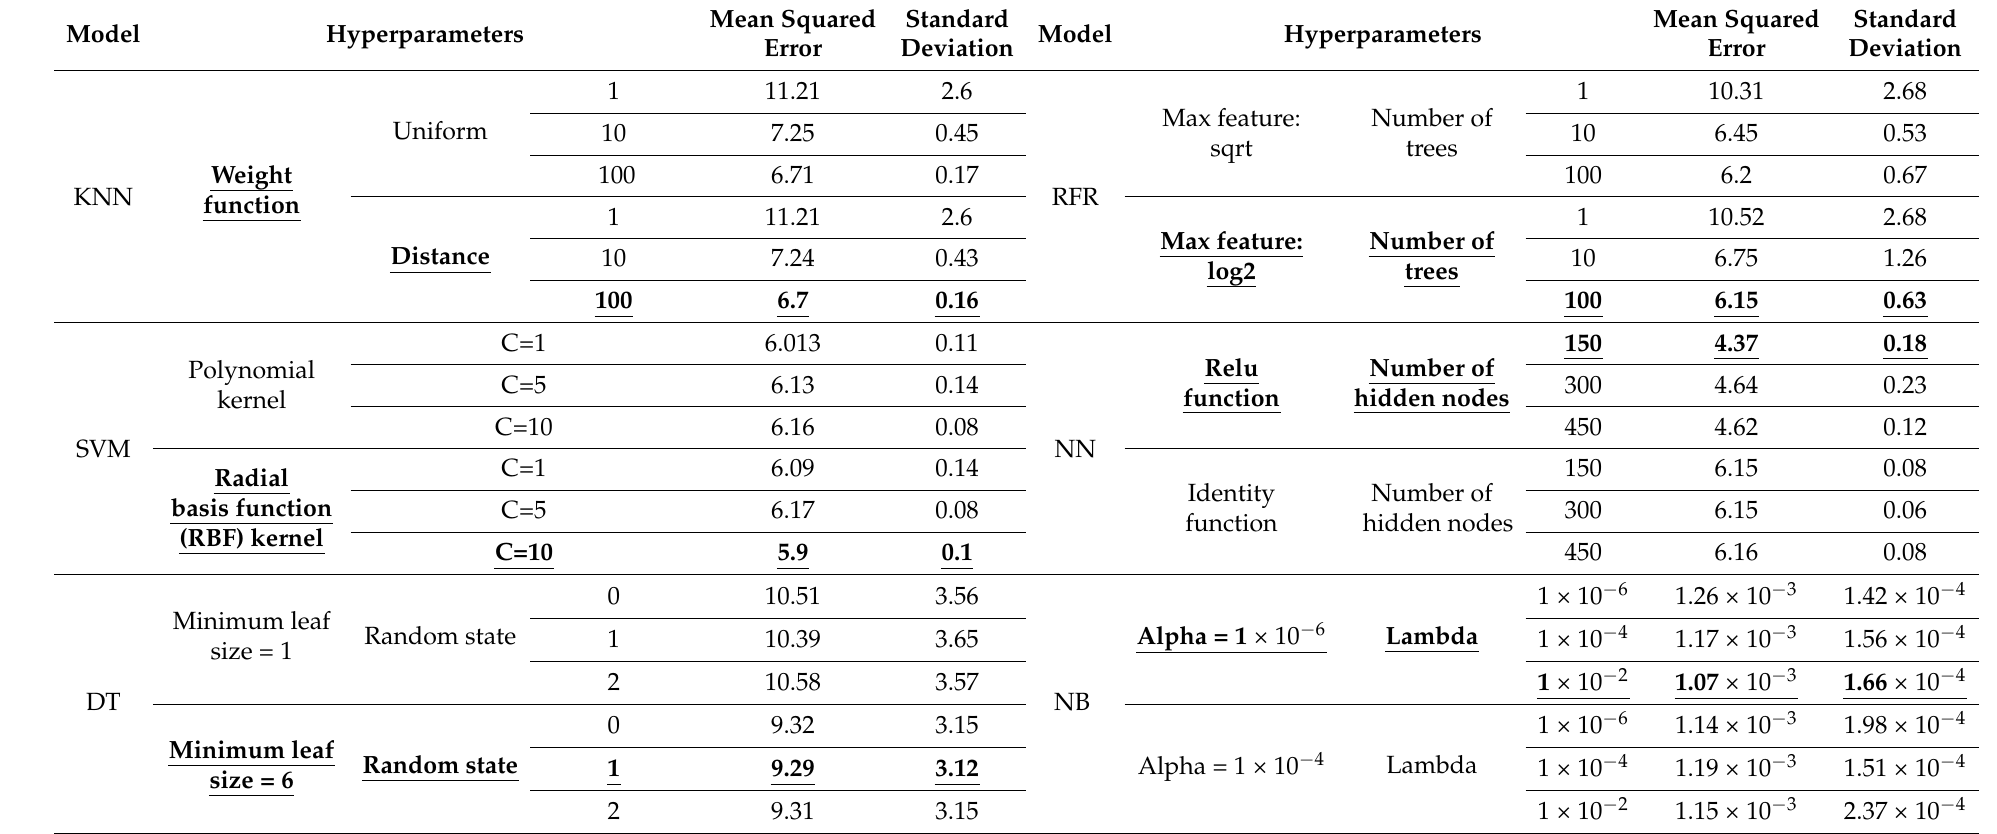
Table 3. Hypertuning parameters for KNN, RF, DNN, DT, NB, HT, NN, and